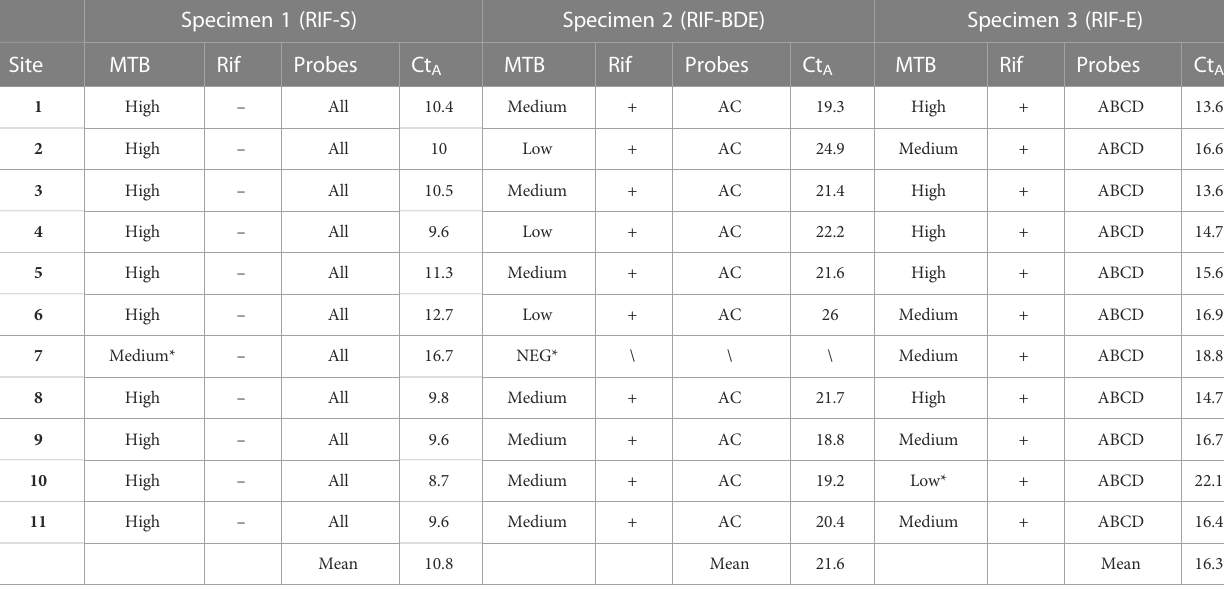
TABLE 2 Discordant results identi fi ed in 11 laboratory sites participating in the